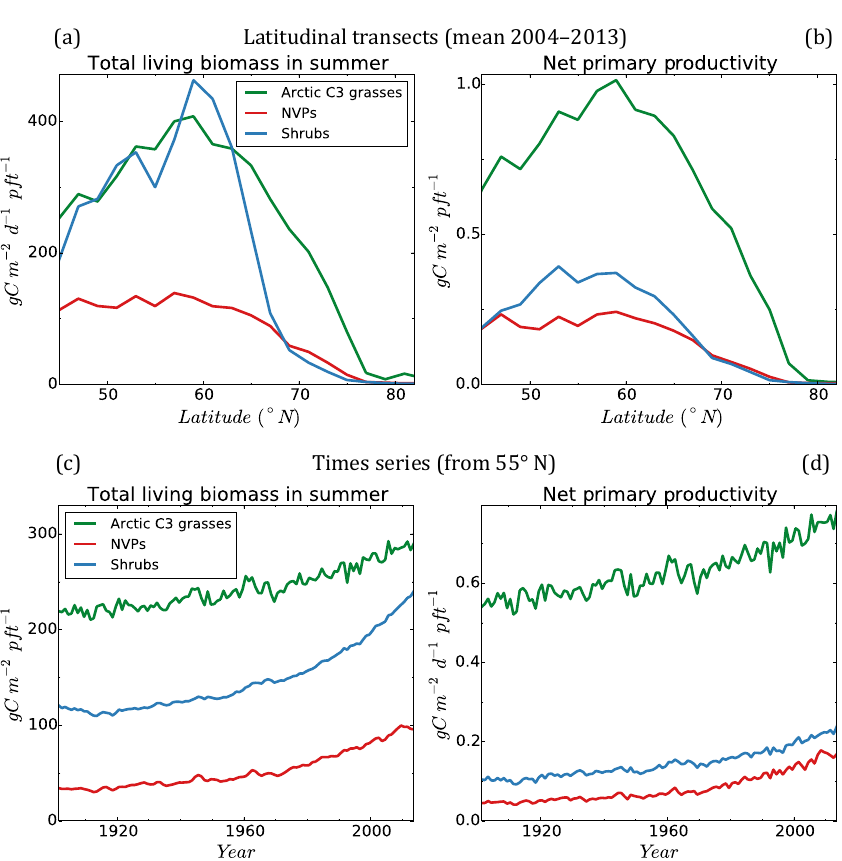
Figure 11. Latitudinal transects (mean 2004–2013, a, b ) and time series (from 55 ◦ N, c, d ) of the total living biomasses (a, c) and the net primary productivity (NPP, b, d ) of new PFTs (boreal C 3 grasses in green, NVPs in red and boreal shrubs in blue), simulated in ORC16. The total living biomasses are the mean of July, August and